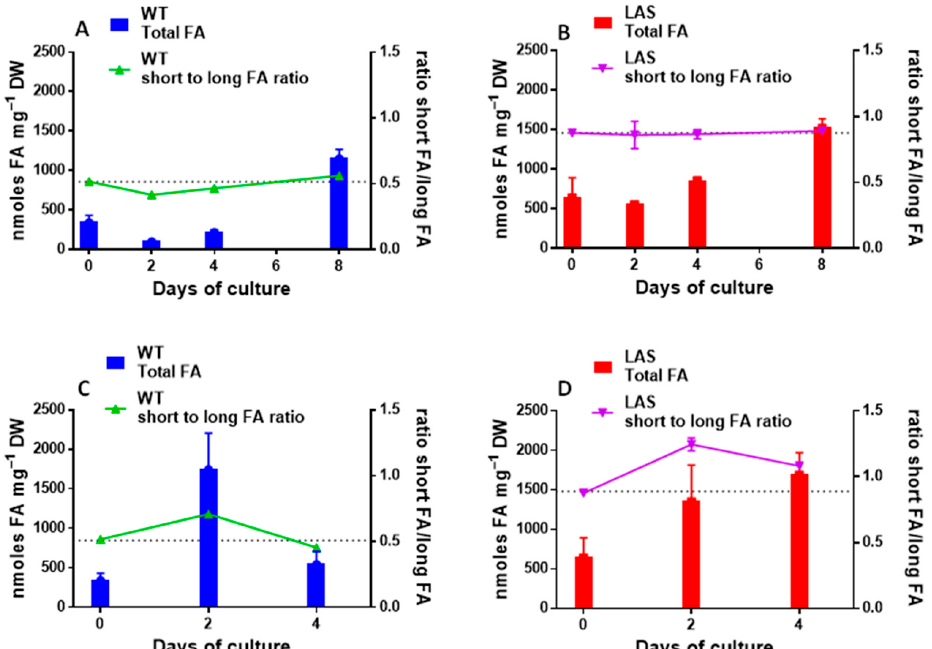
Figure 3. Effect of the medium composition on FA accumulation and short to long FA ratio in WT (blue bars) and LAS (red bars). ( A ) and ( B ) rich (R) medium; ( C ) and ( D ) poor (P) medium. The short to long FA ratio (right Y axis) represents (14. + 15:0 + 16:0) / (22:5 + 22:6). The broken line shows the initial ratio recorded at the beginning of the experiment. Each value is the average of three biological replicates and error bars indicate standard deviation. Graphs and statistics were done with GraphPad Prism ® v7.00 software.